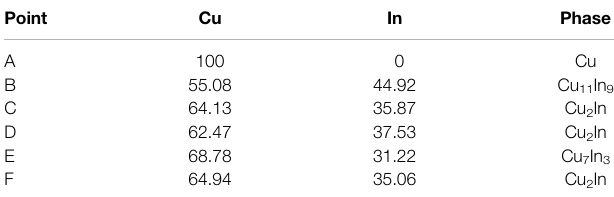
TABLE 1 | The chemical composition (at.%) of each marked point in Figure 4 . Point Cu In